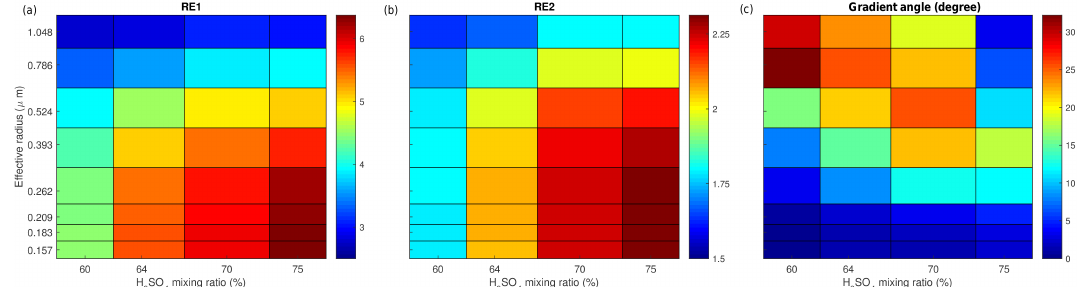
Figure 4. RE1 (a) and RE2 (b) as a function of the effective radius and H 2 SO 4 mixing ratio. Please note the different scaling of the colour bars. Arc cosine of the scalar product ∇ RE 1 · ∇ RE 2 (c) . The gradients are normalised.